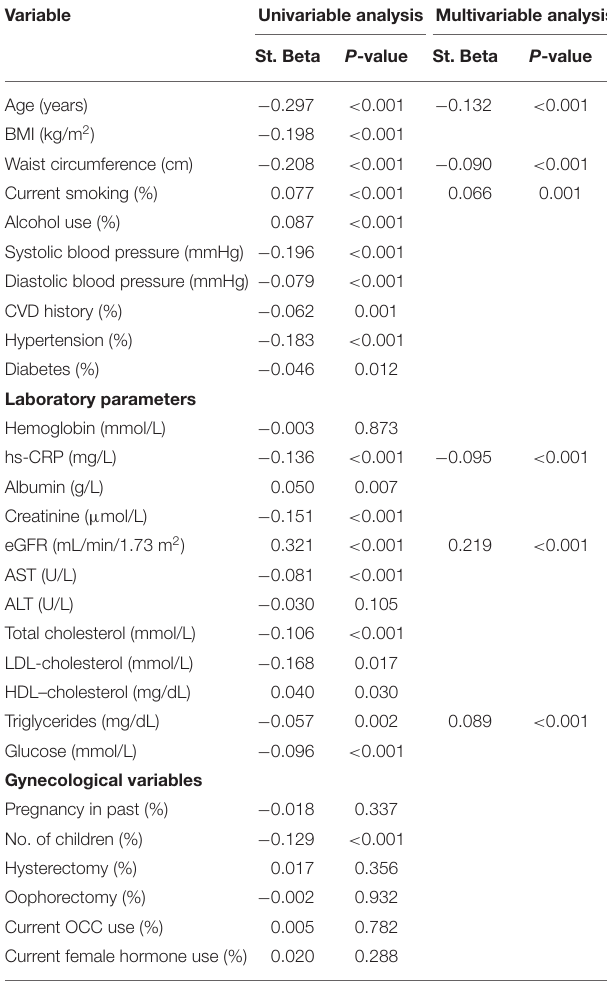
TABLE 2 | Univariable and multivariable linear regression analyses for identification of variables associating with serum free thiol levels in the study population.